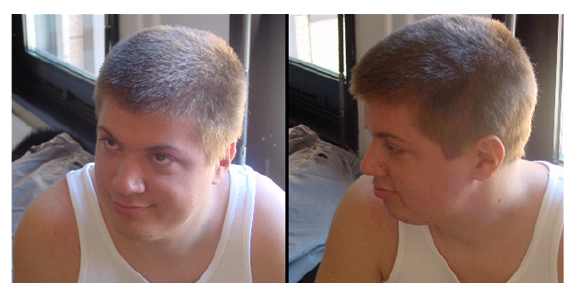
Figure 1. Craniofacial characteristics in patient with 3q13.11q13.33 deletion. Prominent forehead, low hairline, broad nasal bridge, long face, mild degree of hypertelorism with moderate synophrys and thin upper lip can be